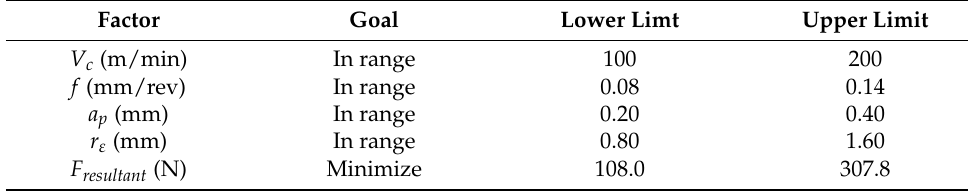
Table 6. Optimization procedure constraints.